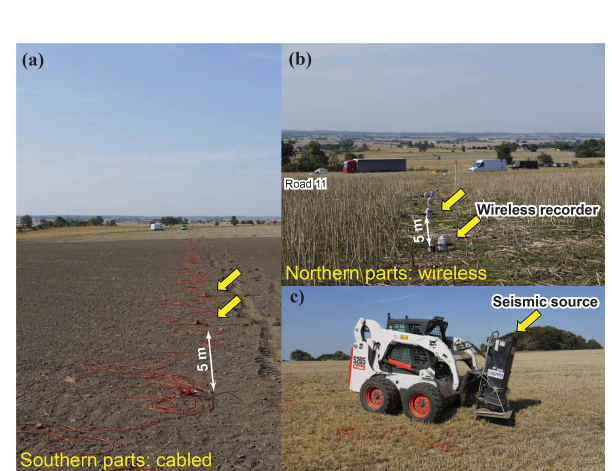
Figure 4. Field photos showing how the seismic data were acquired using a combination of (a) cabled and (b) wireless recorders (con- nected to 10Hz geophones). (c) A 500kg Bobcat-mounted drop hammer was used as the seismic source. Only at a few locations close to Road 11 and on the eastern side of profile 4 when farming was not finished was shooting not